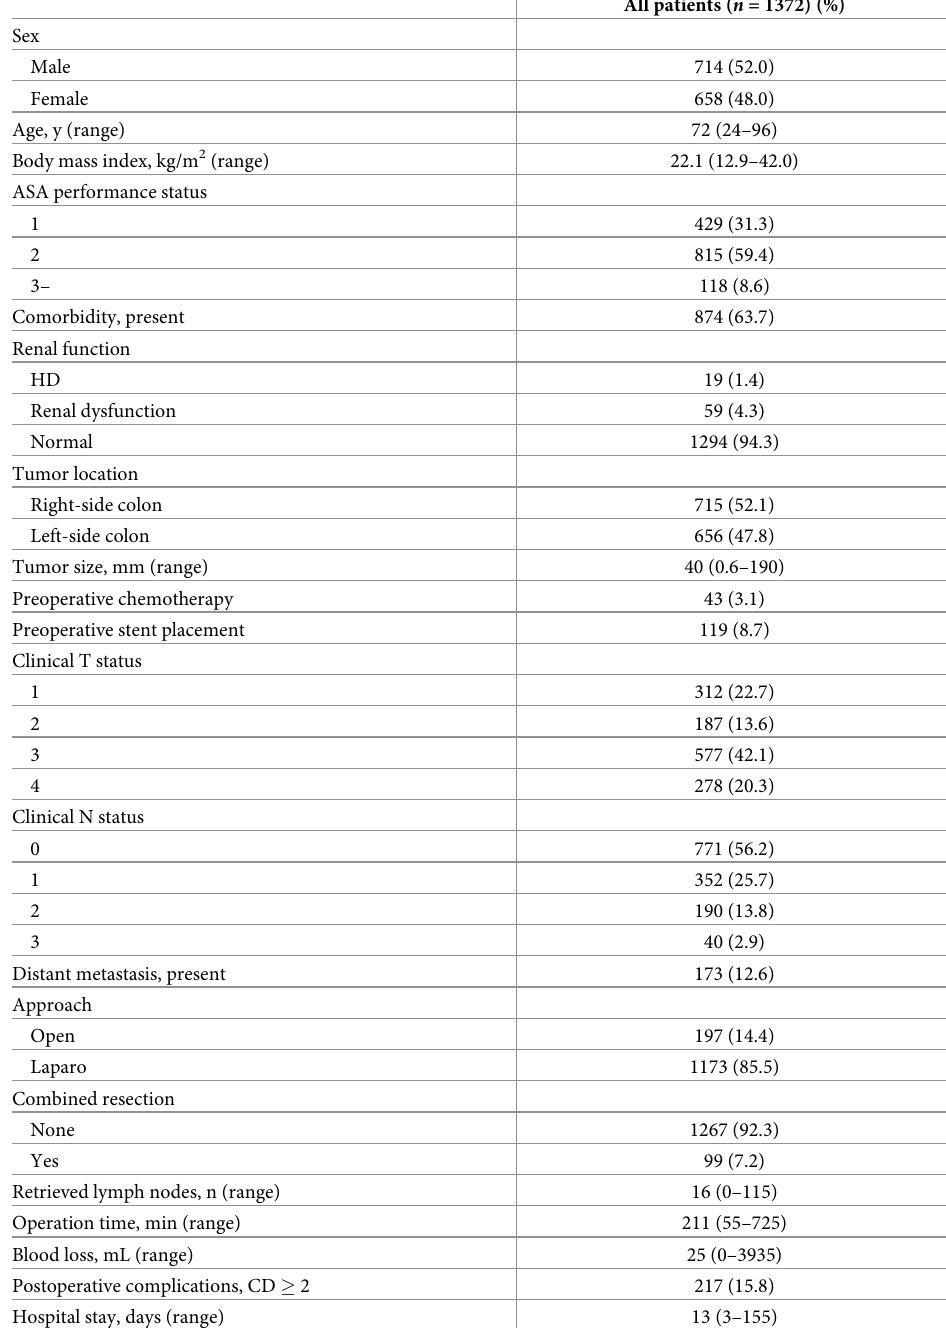
Table 1. Patient